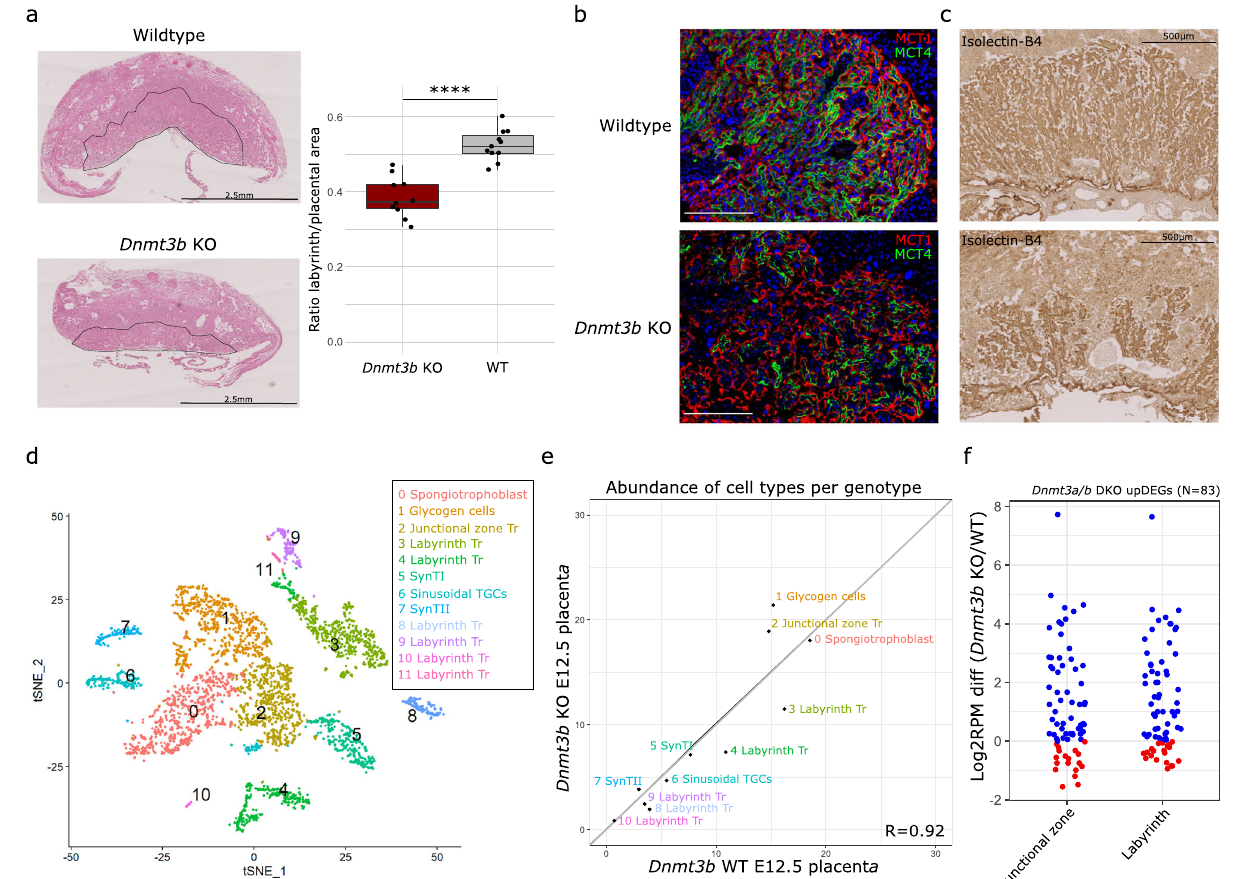
Fig. 4 | Dnmt3b KOs show impaired formation of the placental labyrinth. a RepresentativehaematoxylinandeosinstainingofE12.5placentasfroma Dnmt3b KOandlittermateWTcontrol(left).Thedashedoutlinedregioncorrespondstothe placental labyrinth zone. The boxplot show the ratio of labyrinth to placental area in Dnmt3b KO ( N =11) and WT ( N =10) E12.5 placentas (two-tailed t-test **** p =0.000002) (right). The boxplot centre line is the median, with box limits showing the upper and lower quartiles and whiskers as 1.5x interquartile range. Individual data points are shown as dots. b Immuno fl uorescence for MCT1 and MCT4, which stain for syncytiotrophoblast layer I (SynTI) and SynTII that separate maternal and foetal circulation, respectively, of E12.5 placentas from a Dnmt3b KO andlittermateWTcontrol.Whitescalebar=100 µ m. c RepresentativeisolectinBSI- B4immunohistochemistryofE12.5placentasfroma Dnmt3b KOandlittermateWT control, highlighting the matrix surrounding foetal vessels. d t-distributed